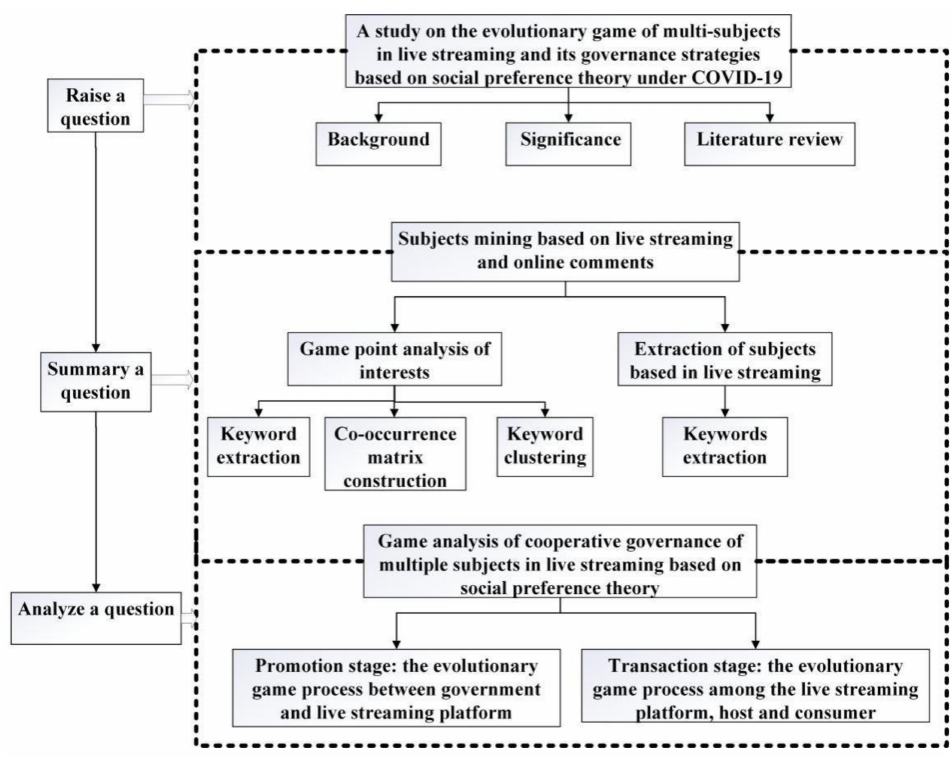
Figure 1. Research